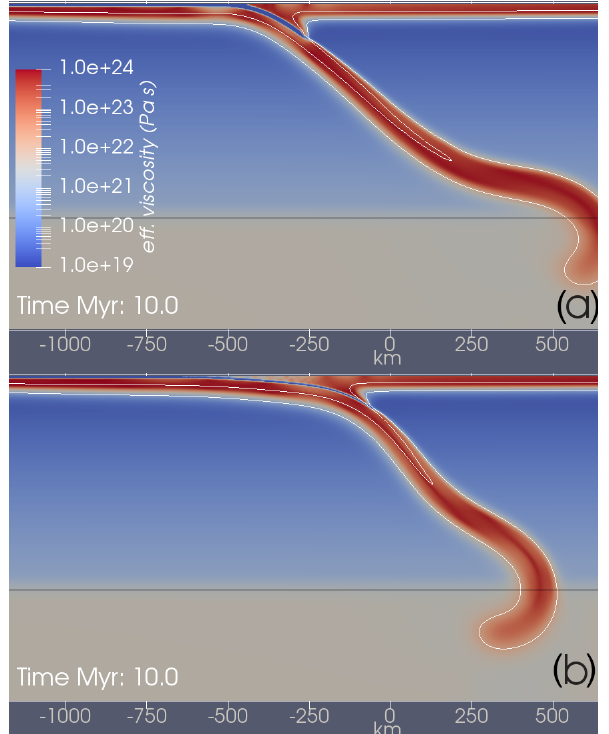
Figure 6. Effect of variable maximum W max in EF models. The colour map shows the effective viscosity at a model time of 10Myr. White lines show isotherms at 700 and 1200 ◦ C. Panel (a) shows the EF model with W max = 1 . 9 × W init = 19km. Panel (b) shows the EF model with W max = W init = 10km. In this case, due to the fact that the subduction interface cannot adjust its thickness, an ex- tremely long, low-angle interface develops, with forearc distances of ∼ 500km.